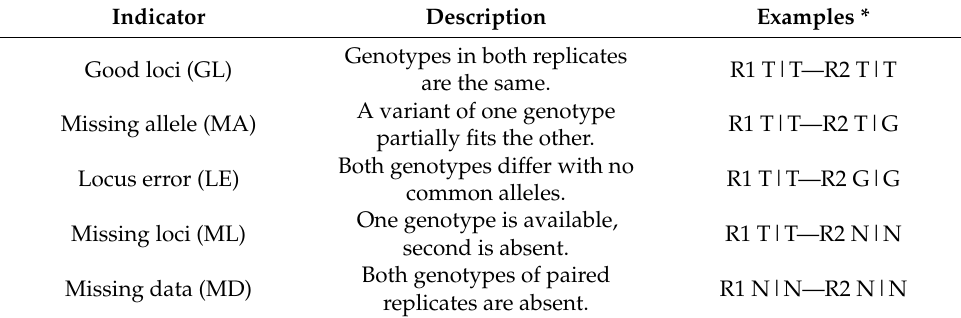
Table 1. Key indicators used to assess genotyping error types. Indicator Description Examples * Genotypes in both Good loci (GL)